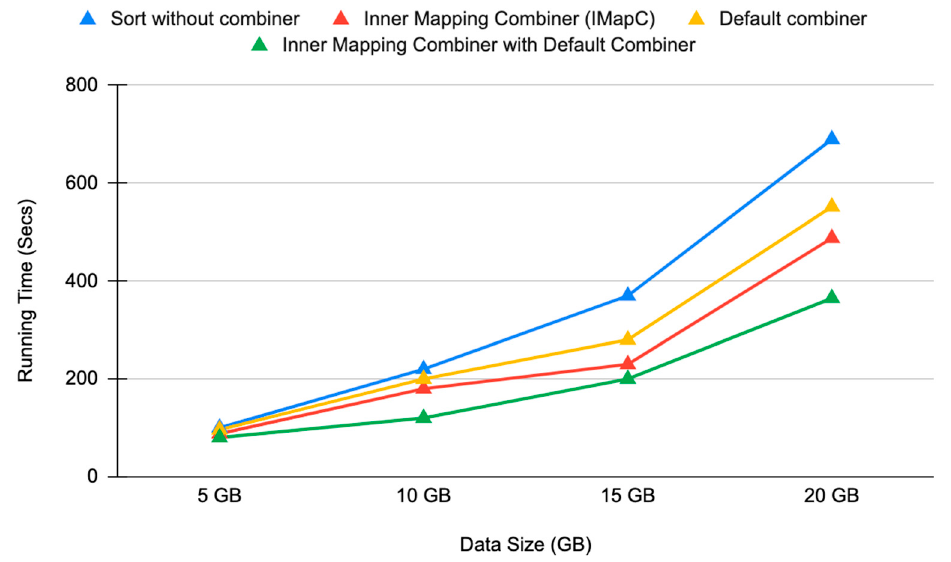
Figure 7. The execution time of the Sort program for Inner Mapping Combiner (IMapC) Over Default Combiner and without Combiner in TFR.